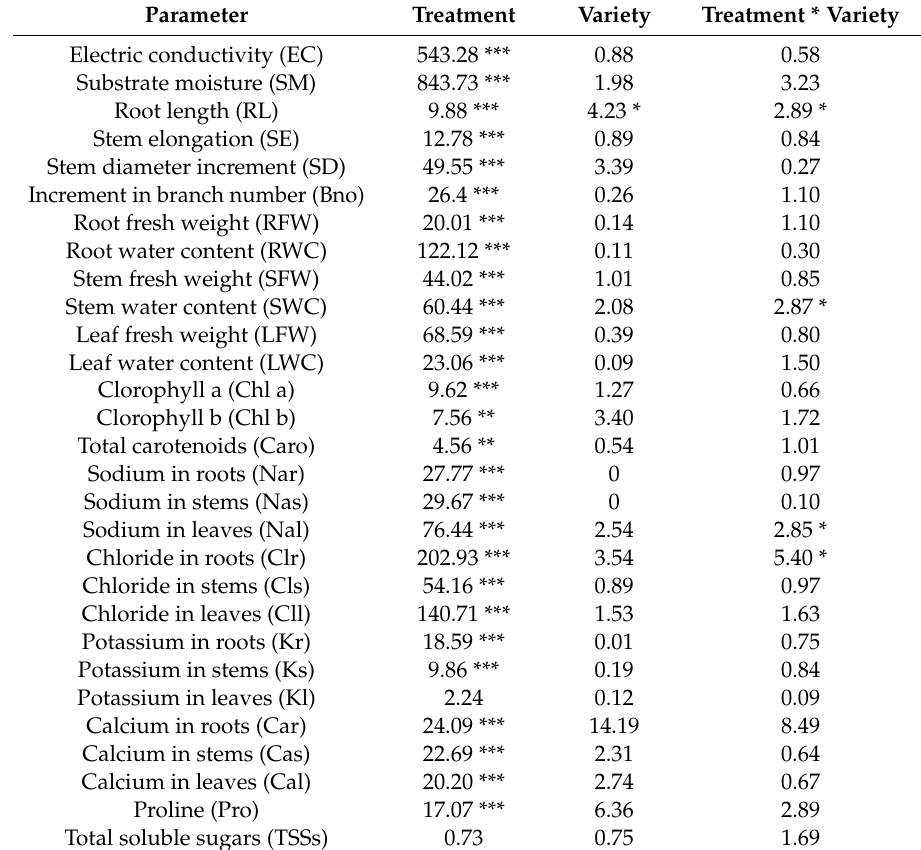
Table 1. Two-way ANOVA (F values and statistical significance) considering the e ff ect of treatment, variety, and interactions on the measured variables, as indicated. ns, *, **, *** indicate non-significant or significant at p < 0.05, p < 0.01, and p < 0.001,